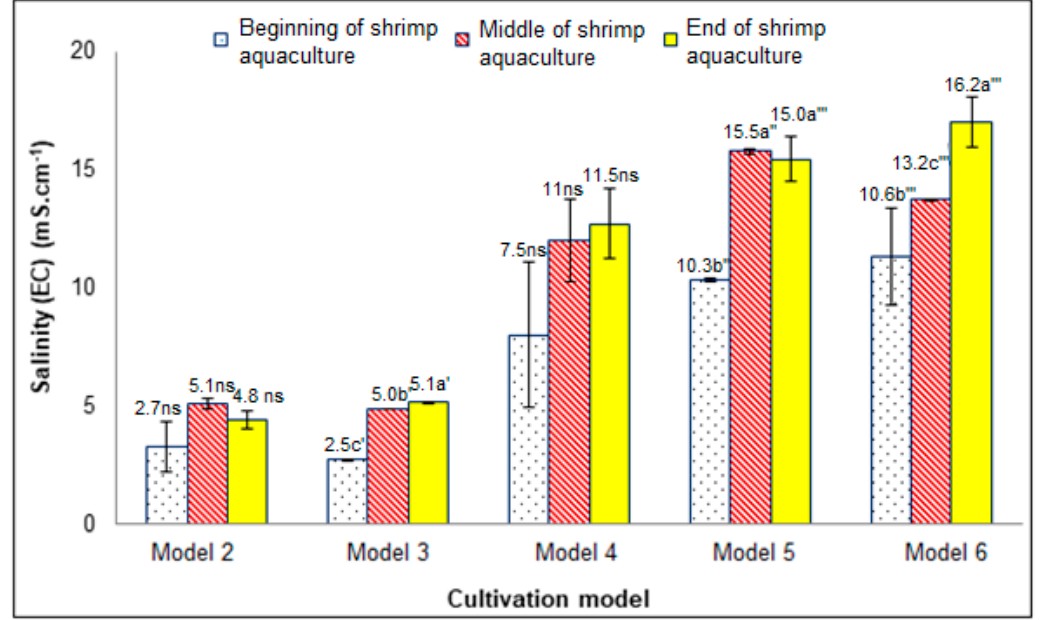
Figure 3. Variations of water salinity in farming models. Notes: a and b are compared according to sampling time, the same letters within the same column or row have no significant difference. The symbols ’, ’’, ’’’ are used to distinguish different experimental or model areas. ns: no difference (compared at a significance level of 5%).